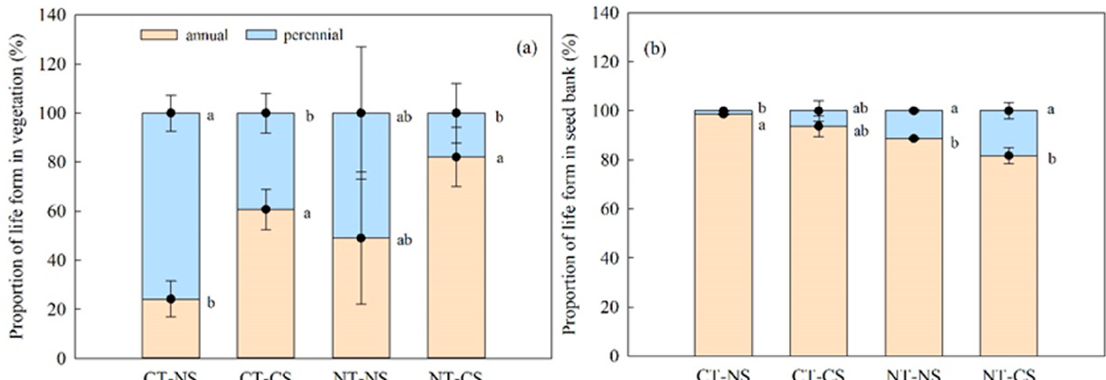
Figure 4. The proportion of life form in vegetation ( a ) and soil seed bank ( b ) under conventional tillage with no crop residue (CT-NS), conventional tillage with crop residue (CT-CS), no-till with no crop residue (NT-NS), and no-till with crop residue (NT-CS). Different letters indicate significant difference among treatments (one-way ANOVA, p < 0.05). Bars represent means ± SE.